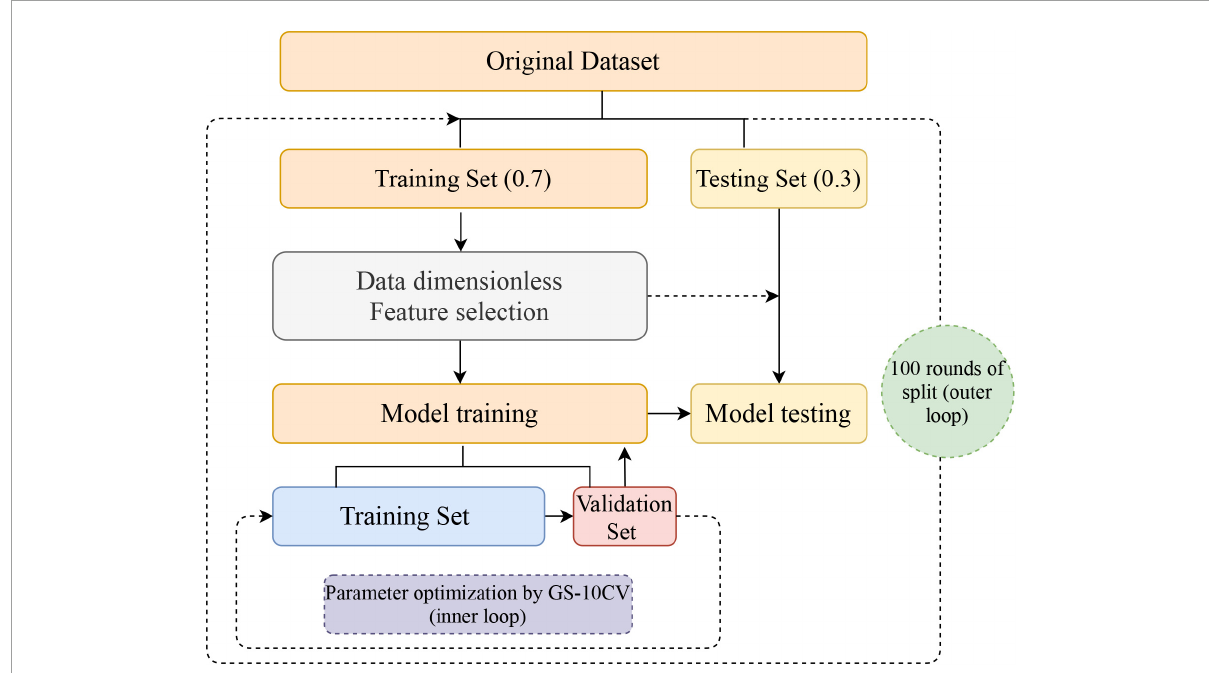
FIGURE1 Flowchart for building a classification model. After 100 nested loops, the mean values of the accuracy, balanced accuracy, the area under the receiver operating characteristic curve, sensitivity, and specificity of the models were generated. GS-10CV, grid-search strategy with 10-fold